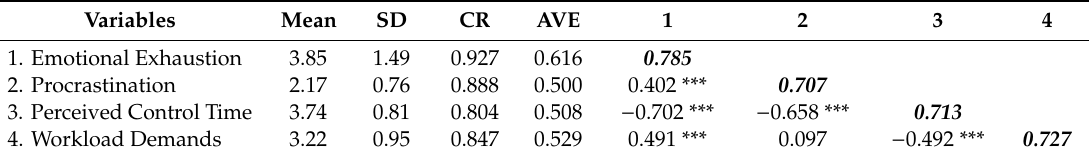
Table 1. Descriptive statistics and confirmatory factor validity and reliability measures for all variables. Variables